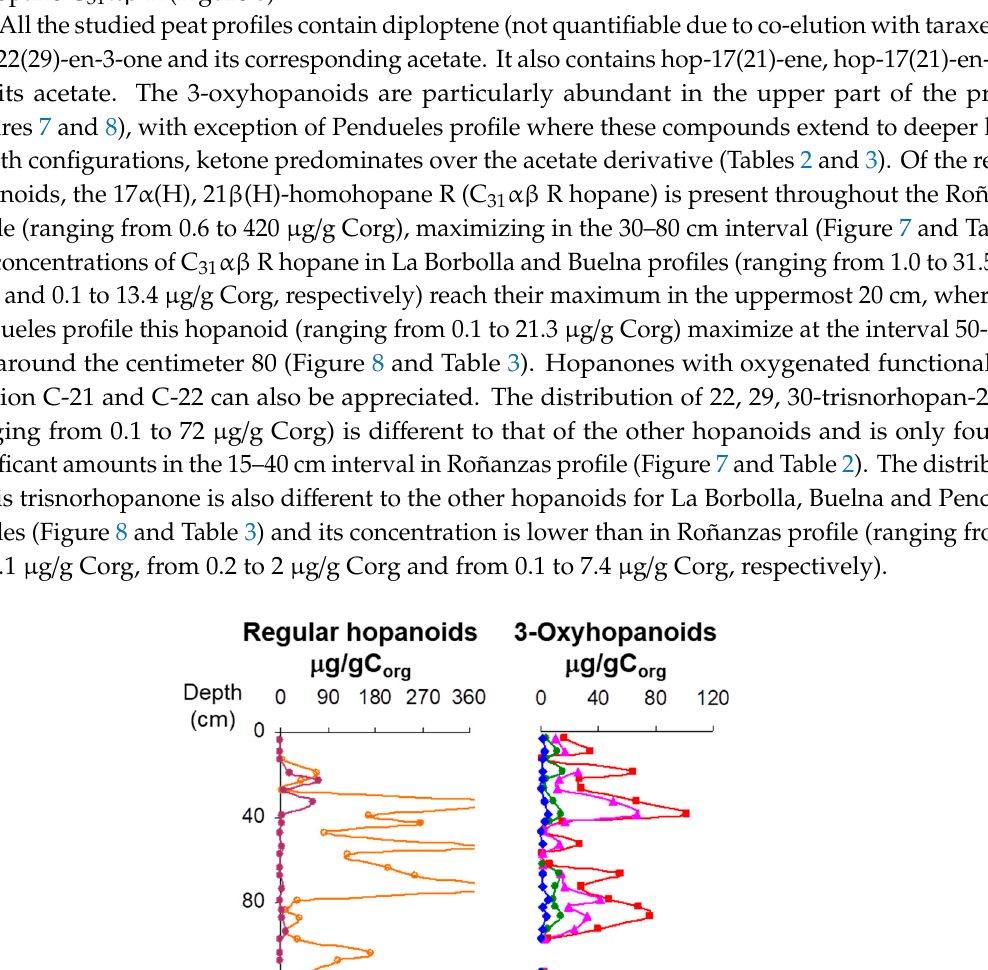
Figure 7. Variation of the concentration of regular and 3-oxyhopanoid derivatives in the Roñanzas profile ( µ g / g